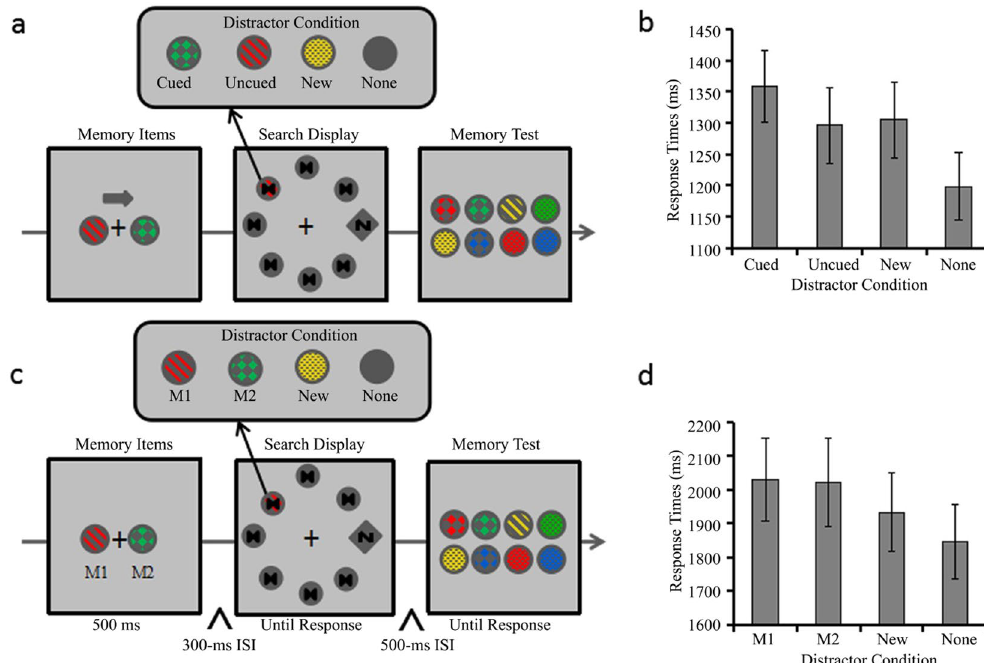
Figure 2. Trial sequences and results for Experiment 2. ( a ) The sequence of events with four possible distractor conditions in a trial for the single cued memory item condition (the Cued distractor condition: the disk’s color and texture was the same as the Cued memorized item; the Uncueddistractor condition: the disk’s color and texture was the same as the Uncued memorized items; the New distractor condition: the disk was in a new color and new texture; the None distractor condition: all seven disks were in gray). ( b ) RTs for the search task as a function of distractor condition in the single cued memory item condition. ( c ) The sequence of events with four possible distractor conditions in a trial of the two memory items condition (the M1, M2 and None distractor conditions were identical to those in Experiment 1, the New distractor condition was the same as its